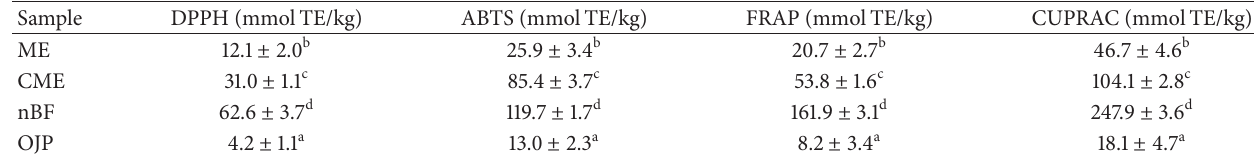
Table 7: Antioxidant activity of O. japonicus tubers extracts determined by the DPPH, ABTS, FRAP, and CUPRAC methods. Sample